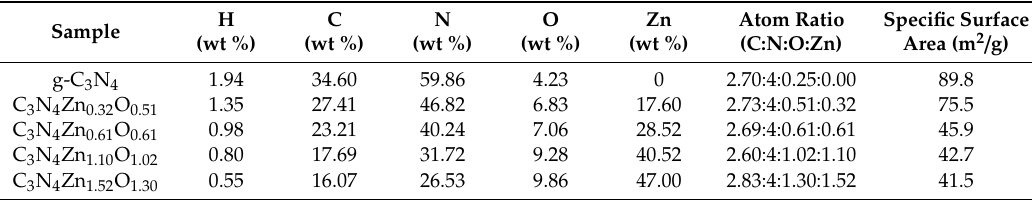
Elemental analysis and specific surface areas of g-C 3 N 4 and C 3 N 4 Zn x O y (x, y = 0.32–1.52)